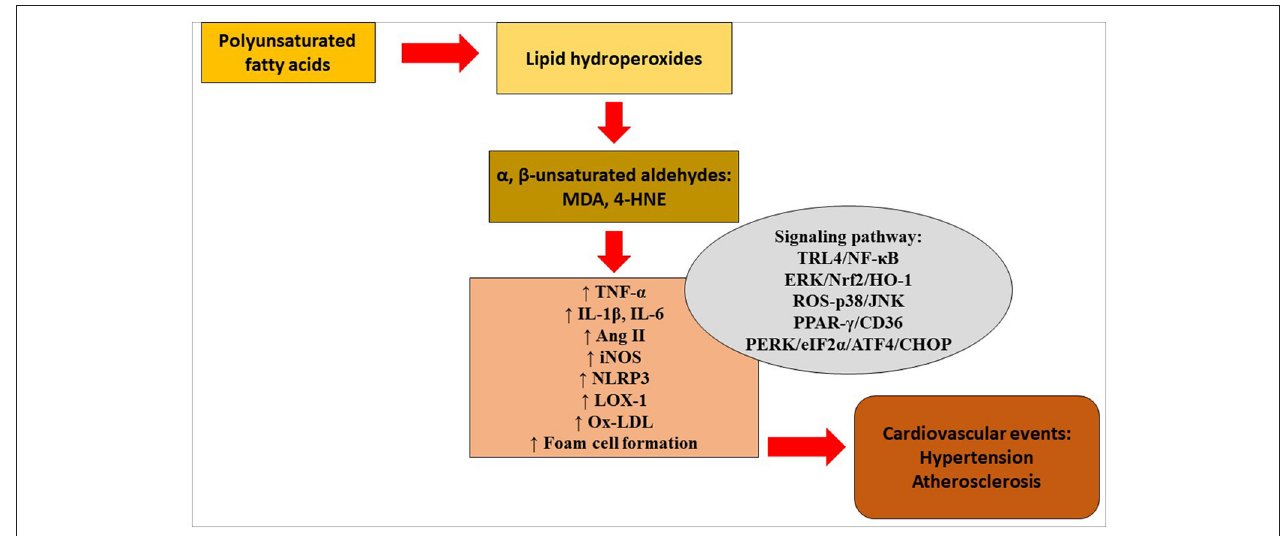
FIGURE 1 | Lipid peroxidation and signaling pathways in the pathogenesis of hypertension and atherosclerosis. 4-HNE, 4-hydroxy-2-nonenal; Ang, angiotensin; ATF4, activating transcription factor 4; CHOP, CEBP homologous protein; eIF2 α , eukaryotic translation initiation factor α ; ERK, extracellular signal-regulated kinase; HO-1, heme oxygenase- 1; IL, interleukin; iNOS, inducible nitric oxide synthase; JNK, c-Jun NH2-terminal kinase; LOX-1, lectin-type oxidized low-density lipoprotein receptor-1; MDA, malondialdehyde; NF- κ B, nuclear factor kappa B; NLRP3, NOD-like receptor protein 3; Nrf2, nuclear transcription factor-E2-related factor